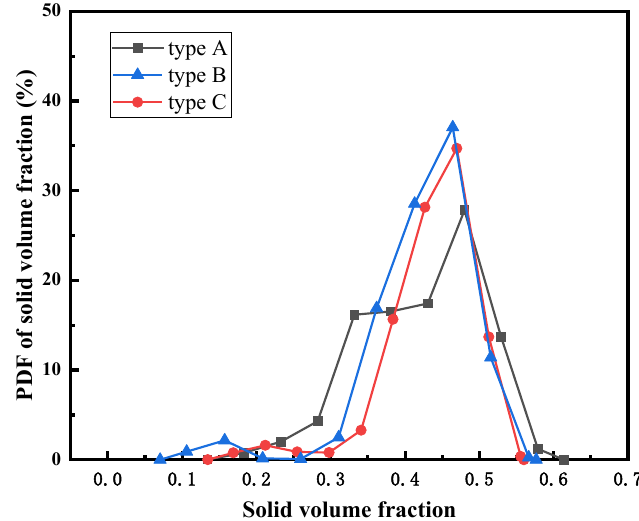
Figure 14. PDF of the solid volume fraction of different feeding structures.